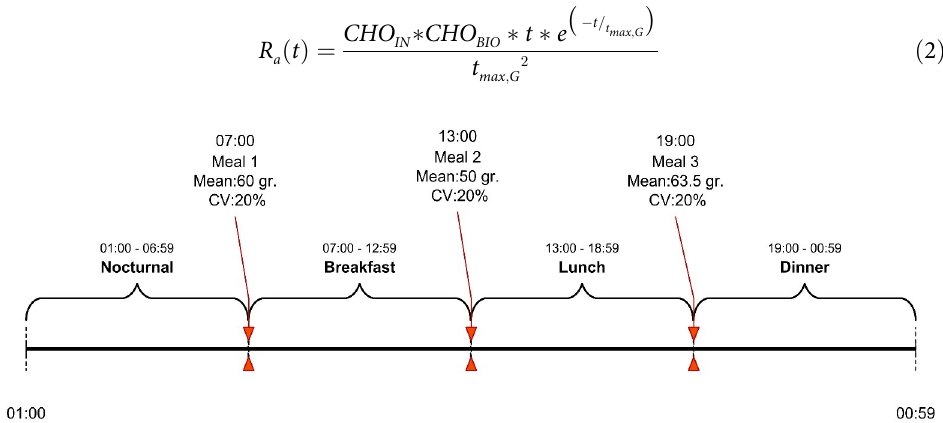
Fig 2. Division of the daily data for piecewise